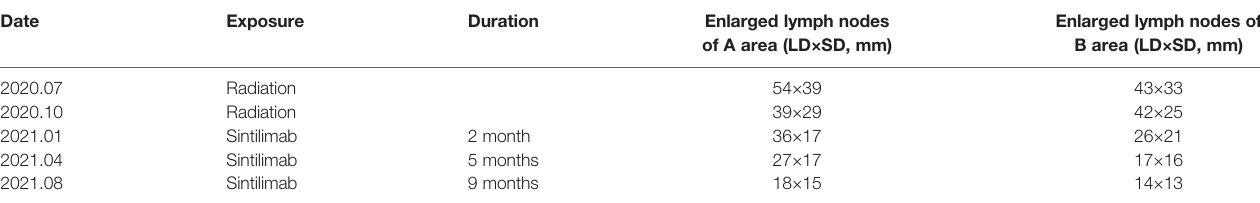
TABLE 1 | Variations of enlarged lymph nodes size after recurrence according to RECIST version